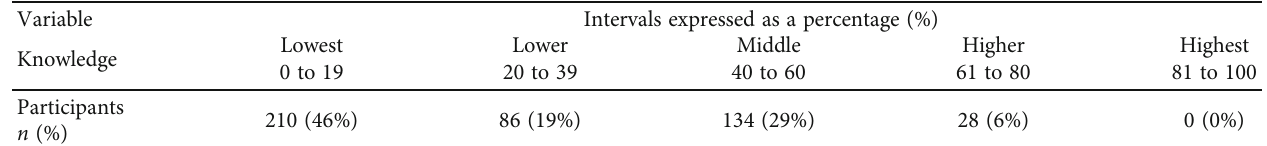
Figure 6: Knowledge about the signs and symptoms of schistosomiasis among study participants. Table 2: Knowledge scores among study participants.